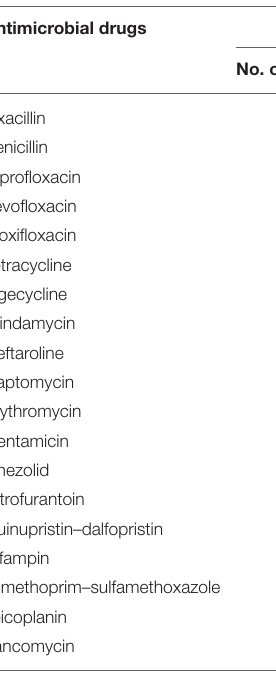
Figure 5 ). Ophthalmology department and outpatient